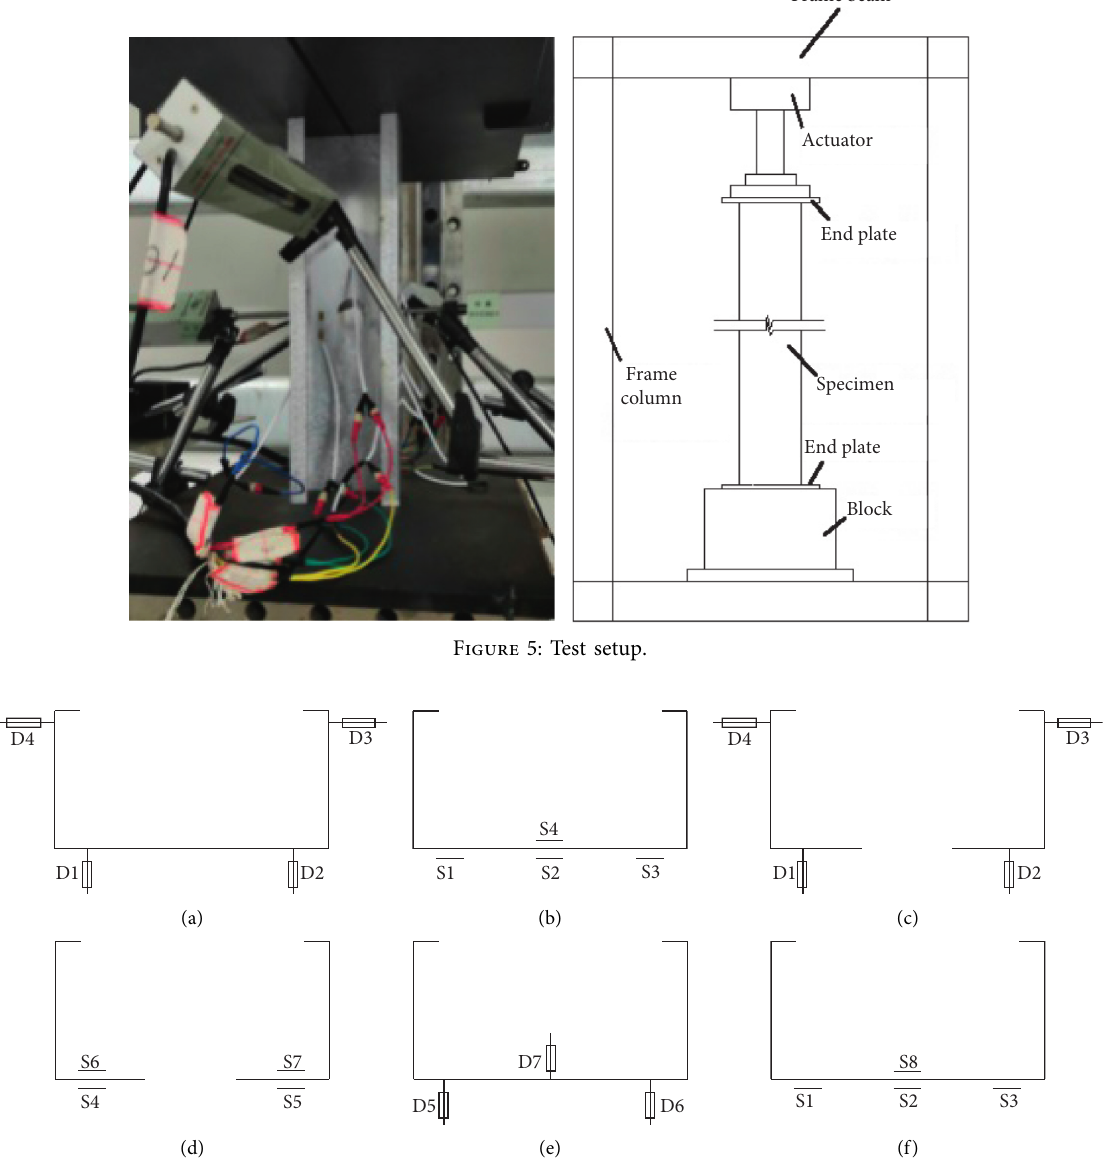
Figure 5: Test setup.